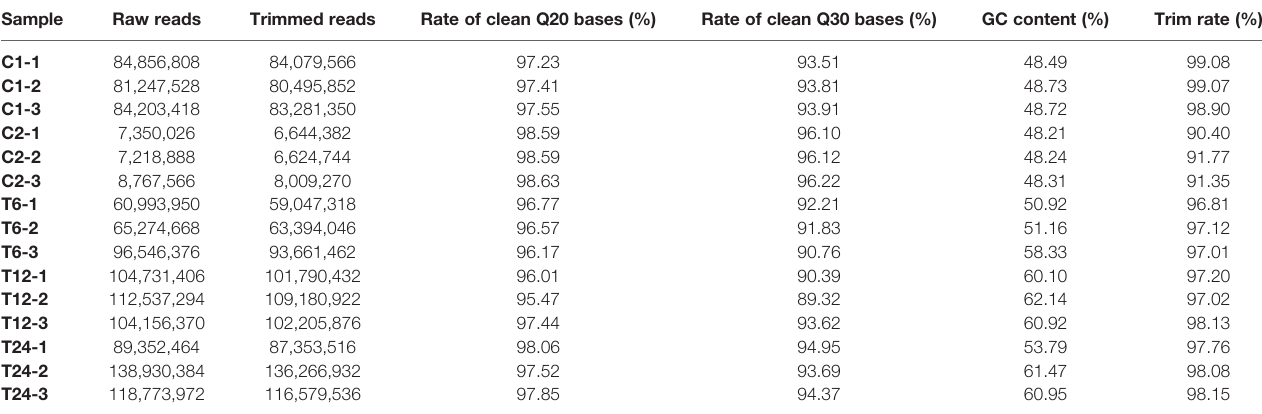
TABLE 2 | Summary of reads obtained from dual RNA transcriptome sequencing. Sample